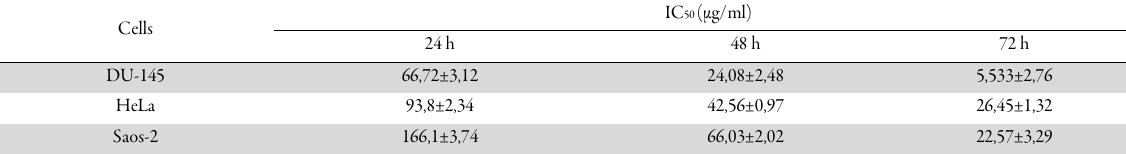
Table 1. Comparison of IC 50 values between Hypericum scabrum L. methanol extract on different cells after 24 h, 48 h and 72 h of incubation Cells